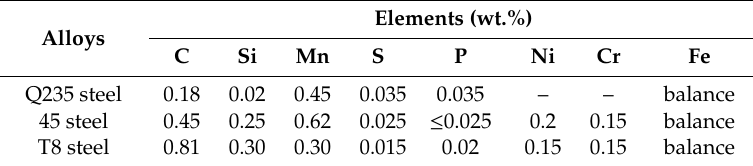
Figure 1. Shape and dimensions of the steel mould. Table 1. Chemical compositions of the carbon steels (wt.%).